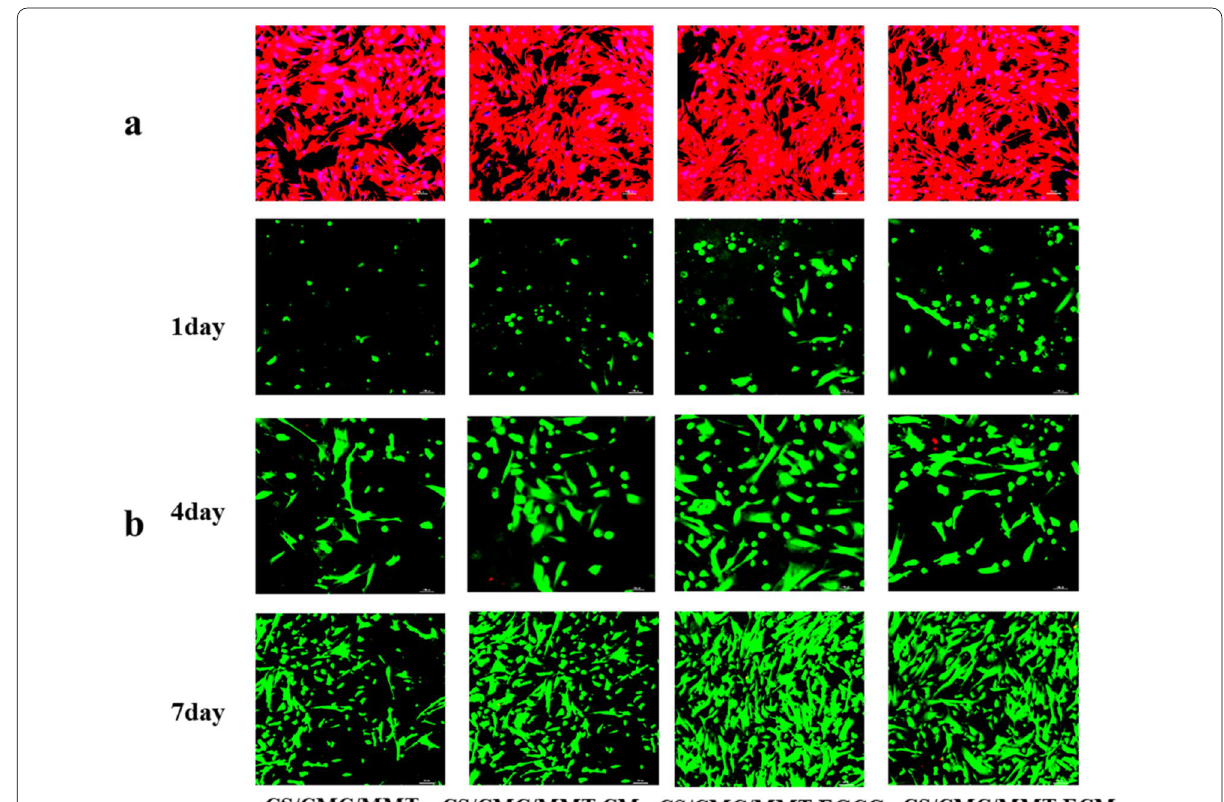
Fig. 8 a Skeleton of the HUMSCs in the scaffolds; red indicates the cell’s skeleton and blue indicates the nucleus (scale bar: 200 μM). b The live/ dead staining of HUMSCs after seeding on the scaffolds for 1 days, 4 days and 7 days; green indicates the live cells and red indicates the dead cells (scale bar: 100